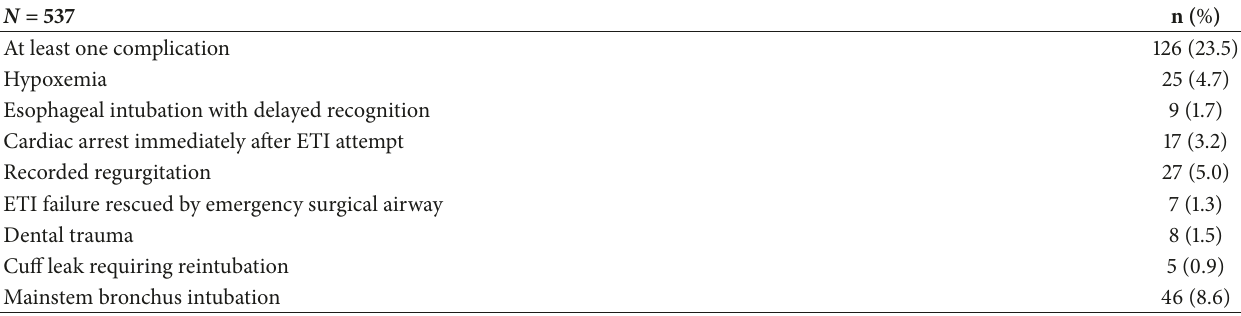
Table 1: Details of airway-related complications in injured patients who underwent ETI in prehospital or emergency department setting. N =